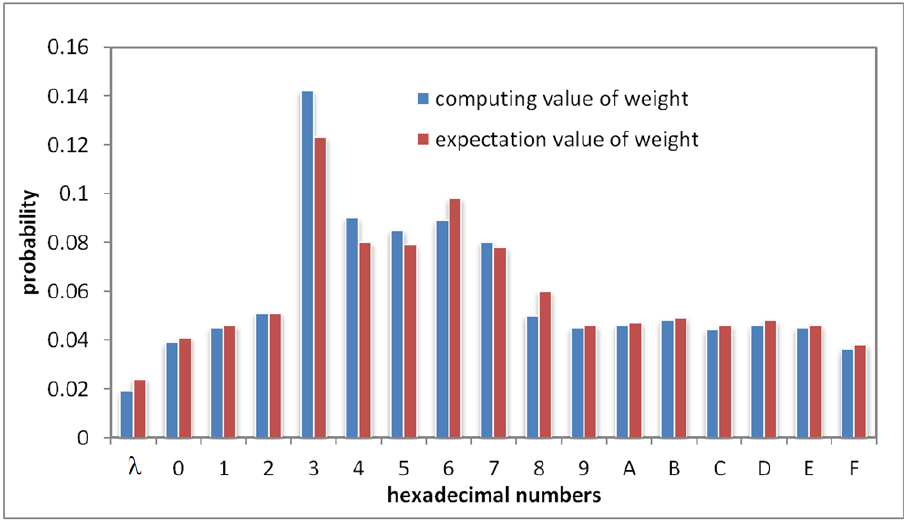
Figure 2. The comparison between the weight value and tests average value of the WRID algo ‐ rithm .